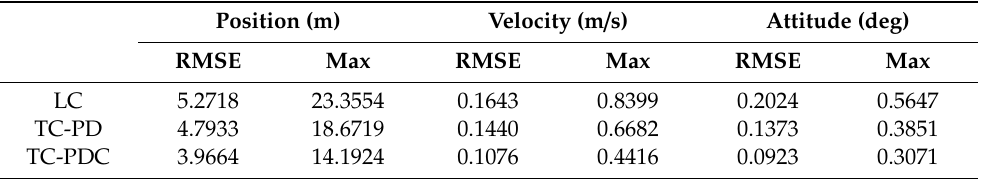
Table 5. RMSE and maximum errors of LC, TC-PD, and TC-PDC with 60-s simulated GNSS outages.